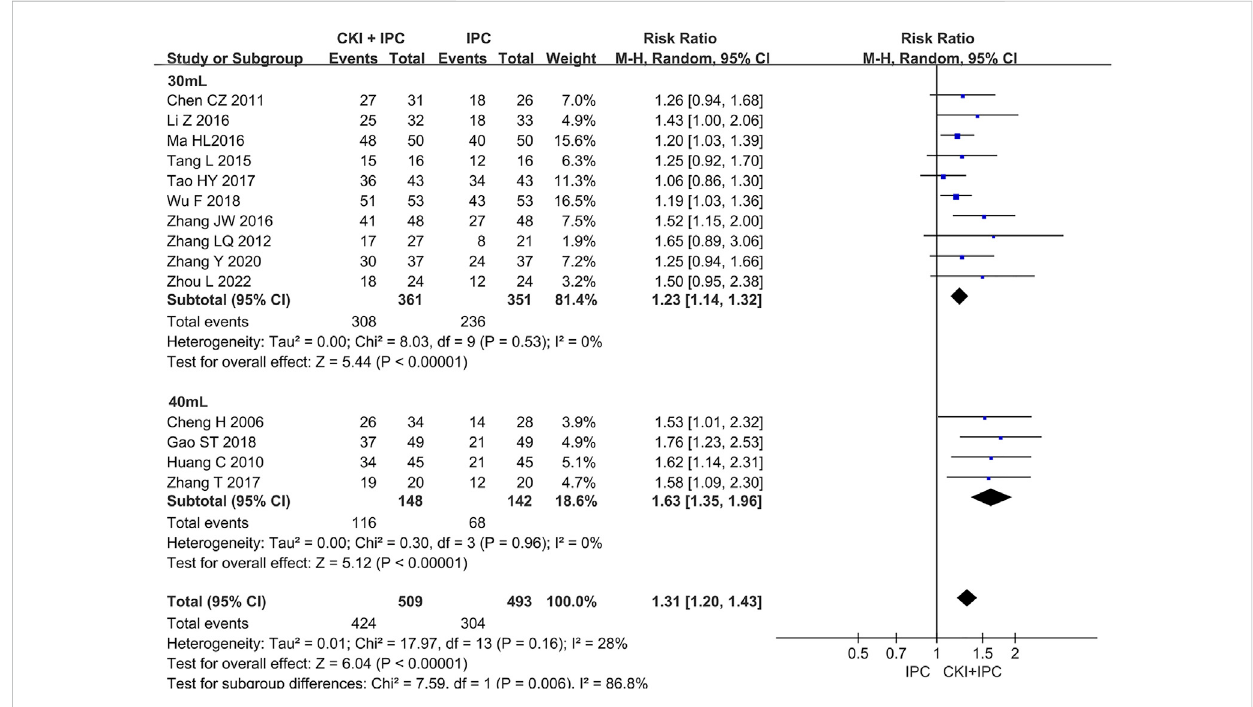
FIGURE 4 Forest plot and pooled risk ratios for the association of objective response rate (ORR) with CKI + IPC and IPC. Subgroup analysis of different CKI